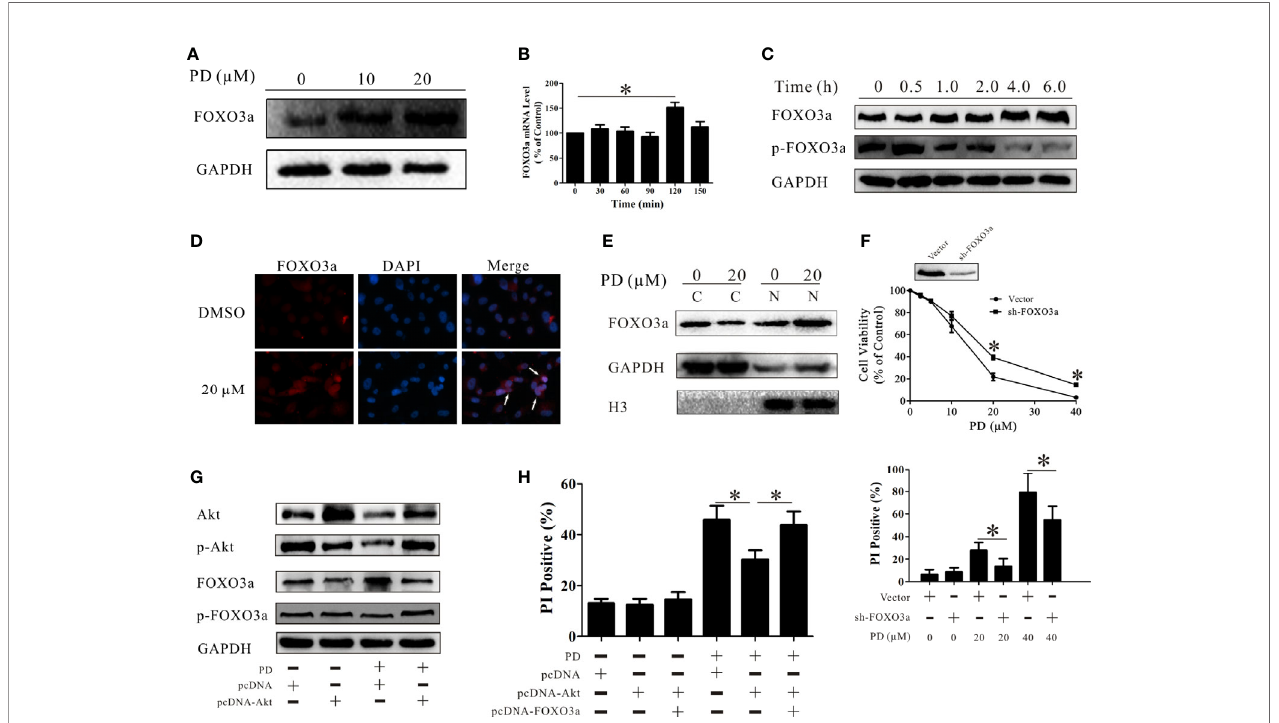
FIGURE 4 | PD induces cell death through the Akt/FOXO3a pathway. (A) Changes in the protein expression level of FOXO3a after treatment of PC3 cells with PD. (B) Changes in the mRNA expression level of FOXO3a after treatment of PC3 cells with 10 m M PD for 6 h. (C) Changes in the protein expression levels of FOXO3a and p-FOXO3a after treatment of PC3 cells with 10 m M PD for 6h. (D, E) The protein expression of FOXO3a in the cytoplasm and nucleus of PC3 cells. (F) The effects of PD on the viability and the PI-positive rate in PC3 cells with FOXO3a inhibition. (G) Changes in the protein expression levels of Akt, p-Akt, FOXO3a and p-FOXO3 after the treatment of PC3 cells transfected with cDNA-Akt with 10 m M of PD for 6 h. (H) The PI-positive rate in cells treated with 20 m M PD for 24 h after transfection with cDNA-Akt alone or cDNA-Akt plus cDNA-FOXO3a. * p <